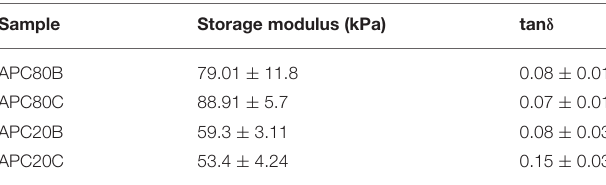
TABLE 3 | Viscoelastic properties of the APC based-sponges under compressive loading at a physiological frequency (1Hz).